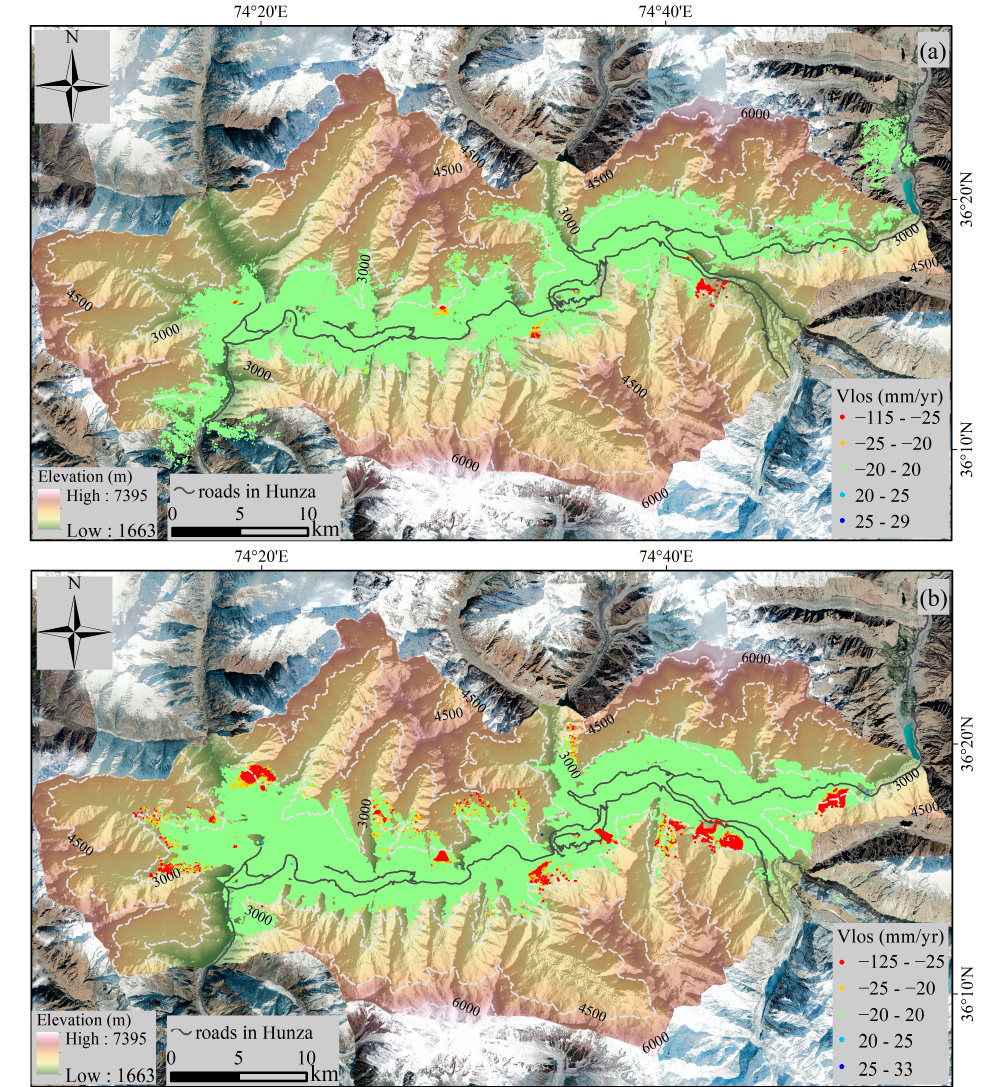
Figure 5. Displacement velocity along the line of sight (V los ) monitored by SBAS-InSAR applying the ascending (Path 27, Frame 117, in ( a )) and descending orbit data (Path 107, Frame 473, in ( b )) Sentinel-1A dataset. The black line represents the roads in the Hunza Valley.